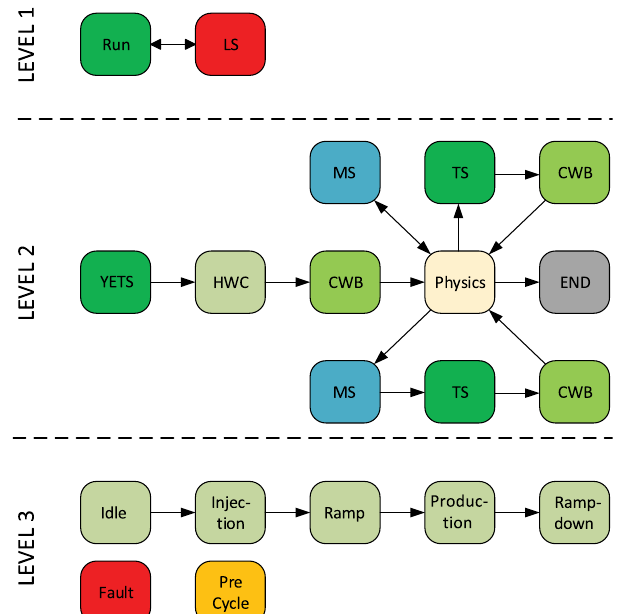
FIG. 9. Three levels of the collider operations model and normal transitions between